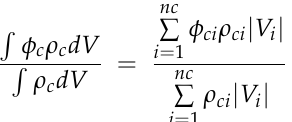
Figure 17. Variation of benchmark oxygen emission concentration of NO x and soot. Since the increase in the hydrogen blending ratio affects the emission of flue gas, the change in the total pollutant emission shall also be analyzed and measured by the mass flow rate of discharged pollutants, mg · s − 1 , as shown in Figure 18. It can be seen from the figure that the total emission of NO x and soot decreases with the increase in the hydrogen blending ratio. The analysis of the reason can focus on the composition of soot. According to the literature [14], the specific heat capacity of water vapor is greater than that of CO 2 and N 2 , which are the main flue gas components. Due to the influence of hydrogen blending, the generation of CO 2 and N 2 decreases, and the generation of H 2 O increases, affecting the change of specific heat capacity in the combustion area. The mass-weighted integral method is used for the entire area, as shown in Equation (3), to obtain the change of specific heat capacity at constant pressure in the combustion area under various hydrogen blending ratio conditions, as also shown in Figure